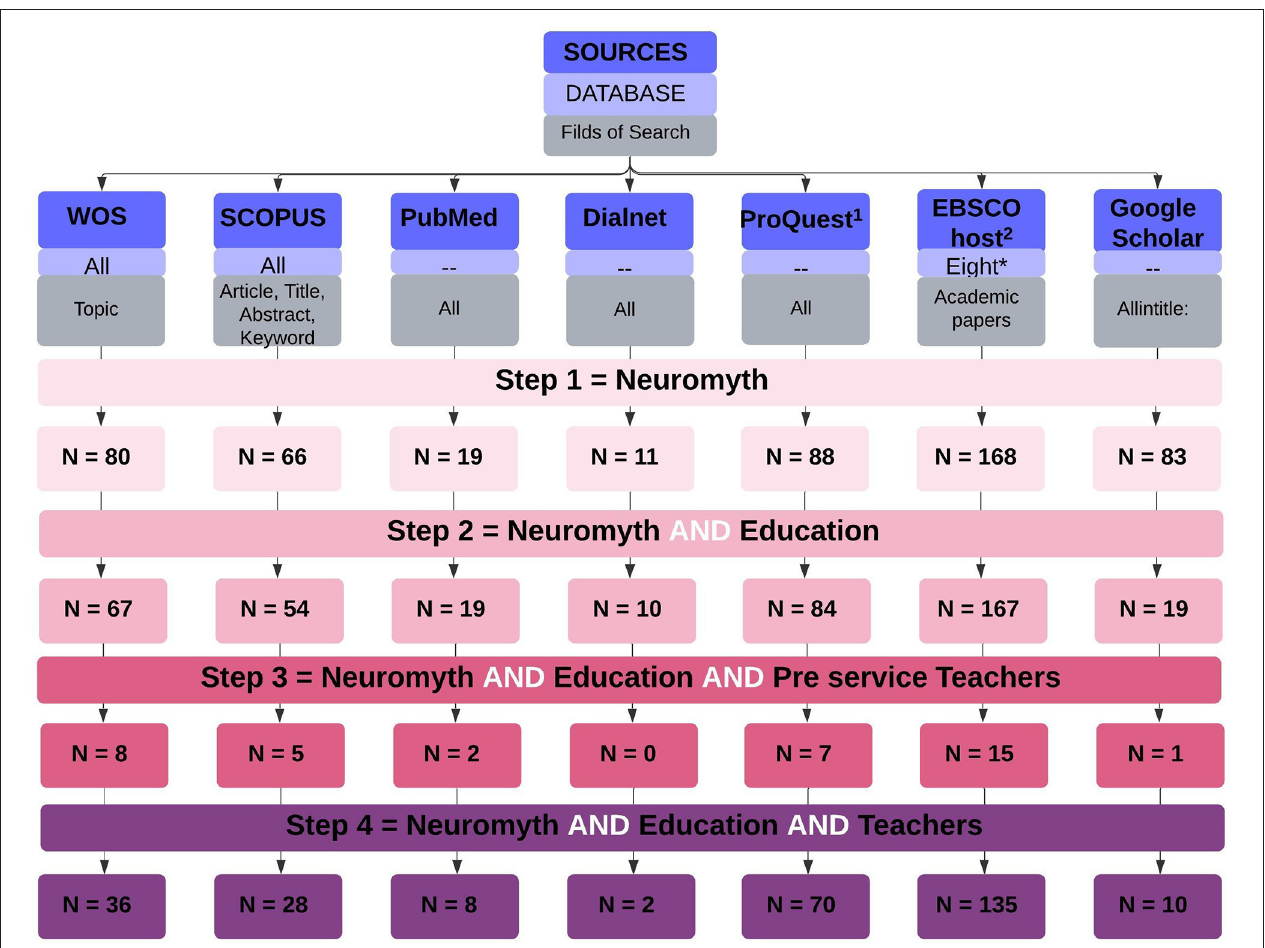
FIGURE 2 | Search strategy and results. The eight* database screened in EBSCOhost are: MEDLINE; Education Source, ERIC, Psychology and Behavioral Sciences Collection; APA PsycINFO, SPORTDiscus with Full Text, Teacher Reference Center, PSICODOC.